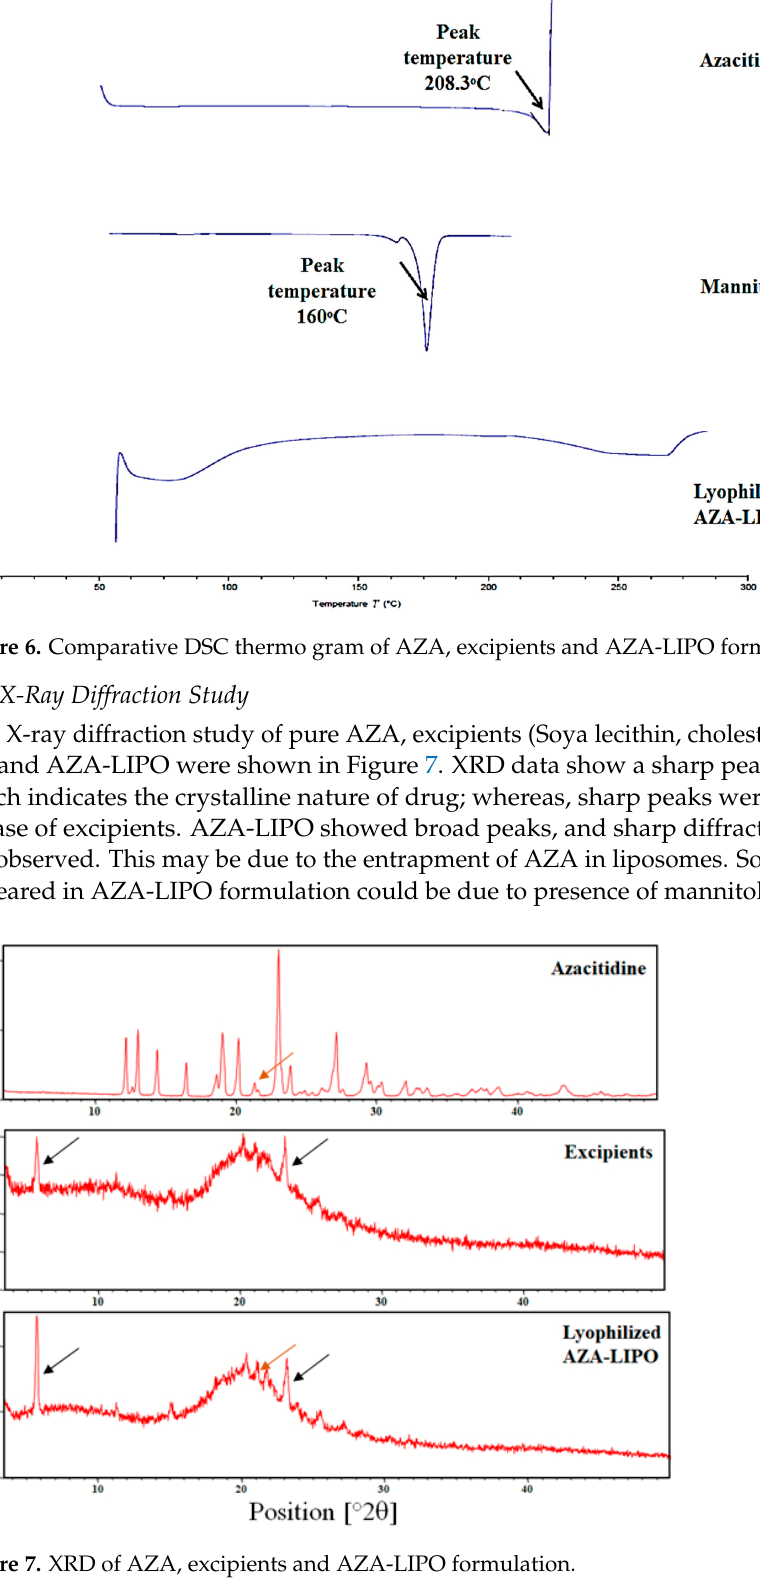
11 of 19 Figure 5. FTIR spectra of AZA, excipients and AZA-LIPO formulation. 3.7. DSC